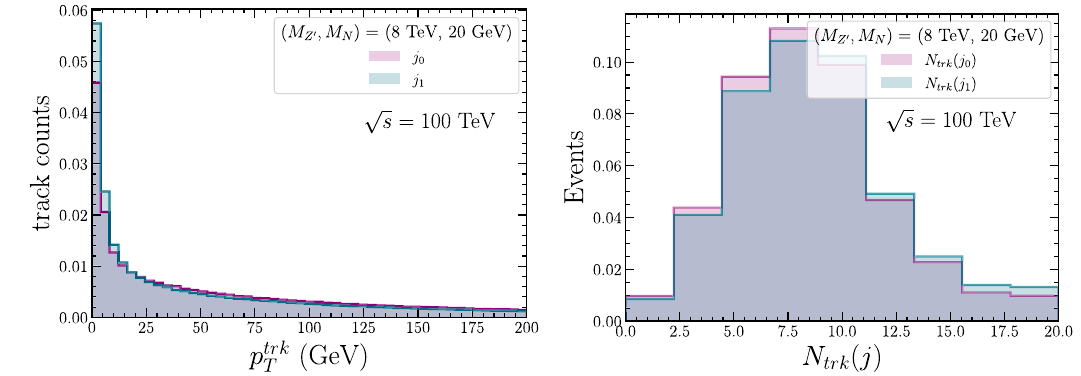
Fig. 13 Left: p T of tracks associated to leading and sub-leading jets, relevant for FCC-hh. Right: Number of tracks associated to j 0 , 1 for FCC-hh